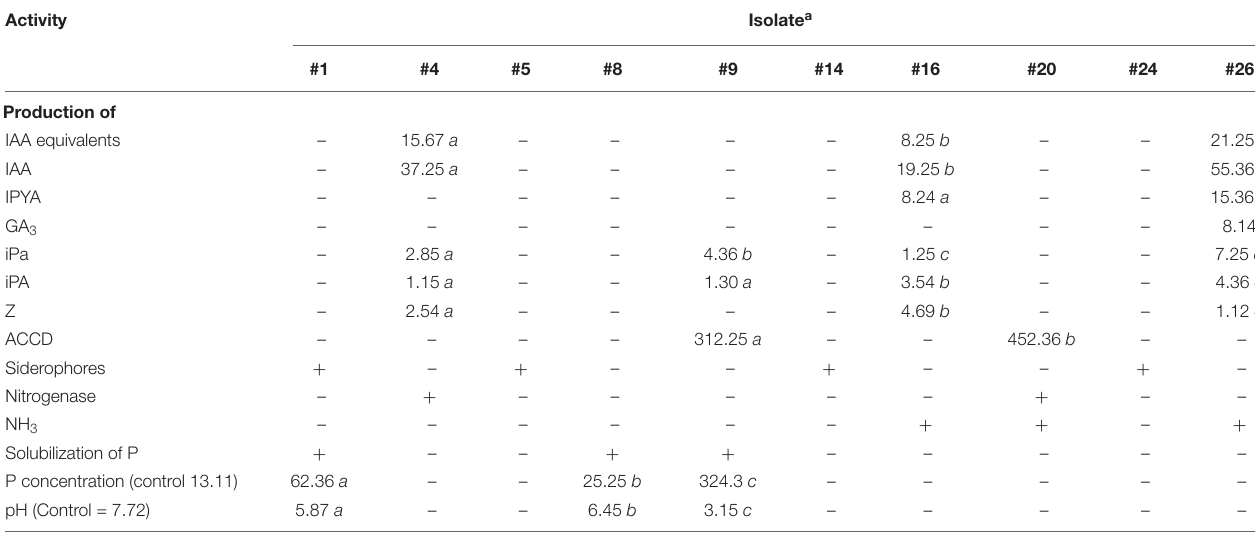
TABLE 2 | In vitro production of PGRs ( µ g ml − 1 ), ACCD (nanomoles α -keto-butyrate mg − 1 protein h − 1 ), siderophores, nitrogenase enzyme, and NH 3 ; and effect of inoculation with RP amended Pikovskaya’s broth by halotolerant PA-producing actinobacteria isolated from mangrove roots on pH levels and concentration of available P (mg l − 1